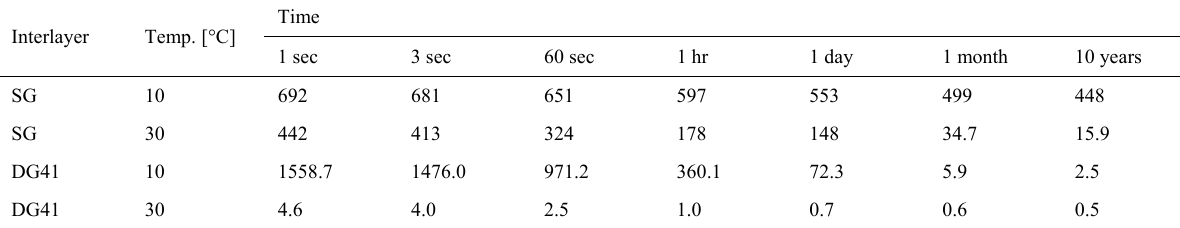
Table 4: Young’s modulus E [MPa] for SG and DG41